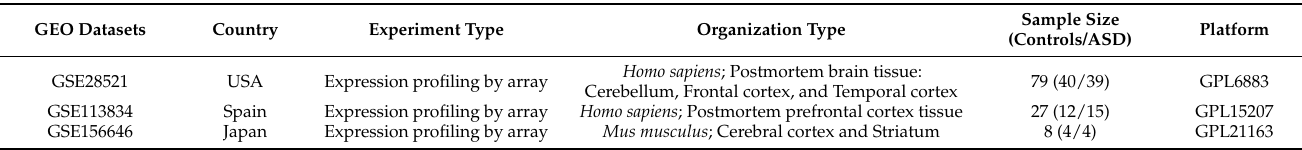
Table 1. The characteristics of the three datasets in the